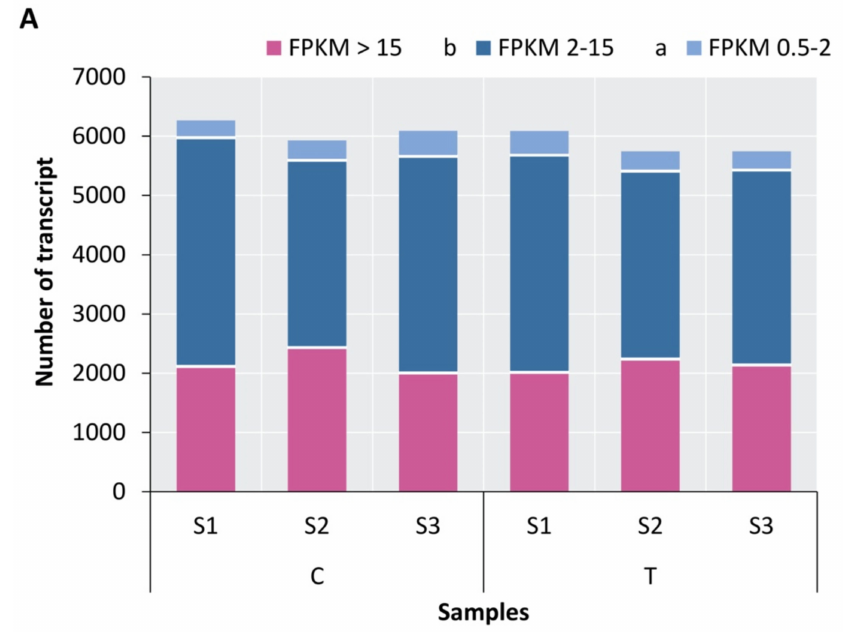
Figure 3. KOG categories of the annotated unigenes. The x-axis represents the names of the 25 groups, and the y-axis corresponds to the percentage of the number of genes in the group out of the total number of annotated genes (https://www.ncbi.nlm.nih.gov/COG/ (accessed on 10 February 2022), E values cutoff 1 × 10 − 3